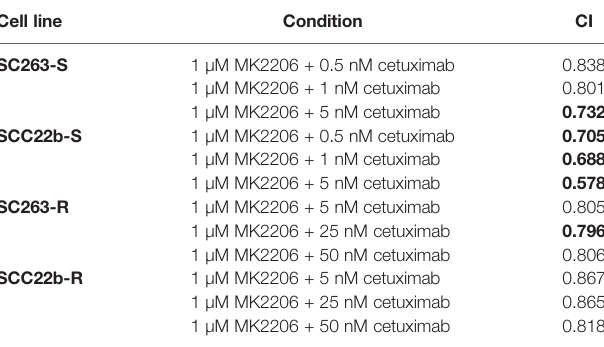
TABLE 4 | CI for HNSCC cell lines after treatment with cetuximab for 168h with 1 µM MK2206 added during the last 72h of treatment. Cell line